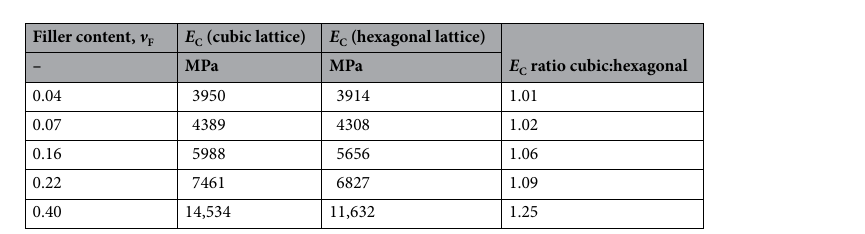
Table 5. FEA calculated filler volume content dependent Young’s moduli of cubic and hexagonal lattice arrangements of EV with E M = 3200 MPa, E F = 63,000 MPa, µ M = 0.42 and µ F = 0.22.